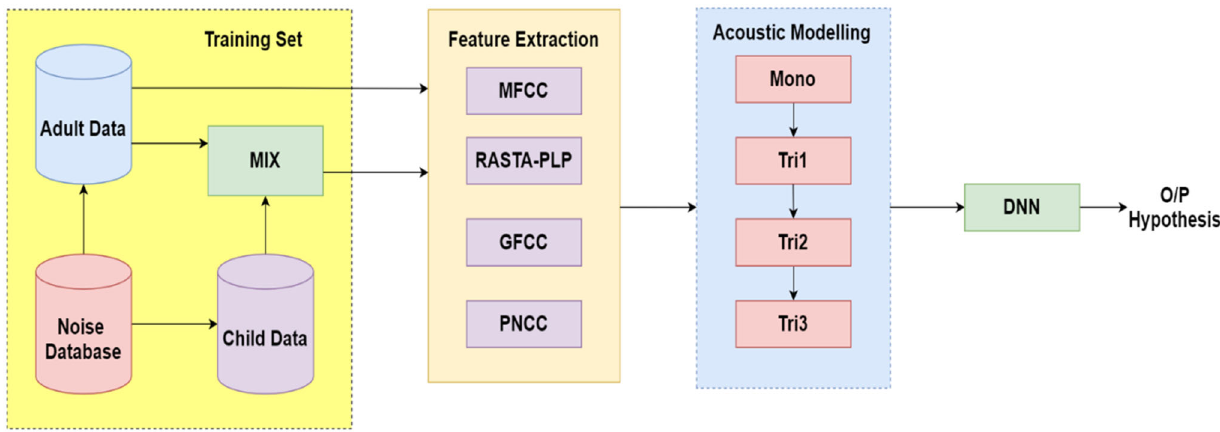
Fig. 4 Basic block diagram of heterogeneous feature extraction-based ASR framework on true matched and mismatched systems